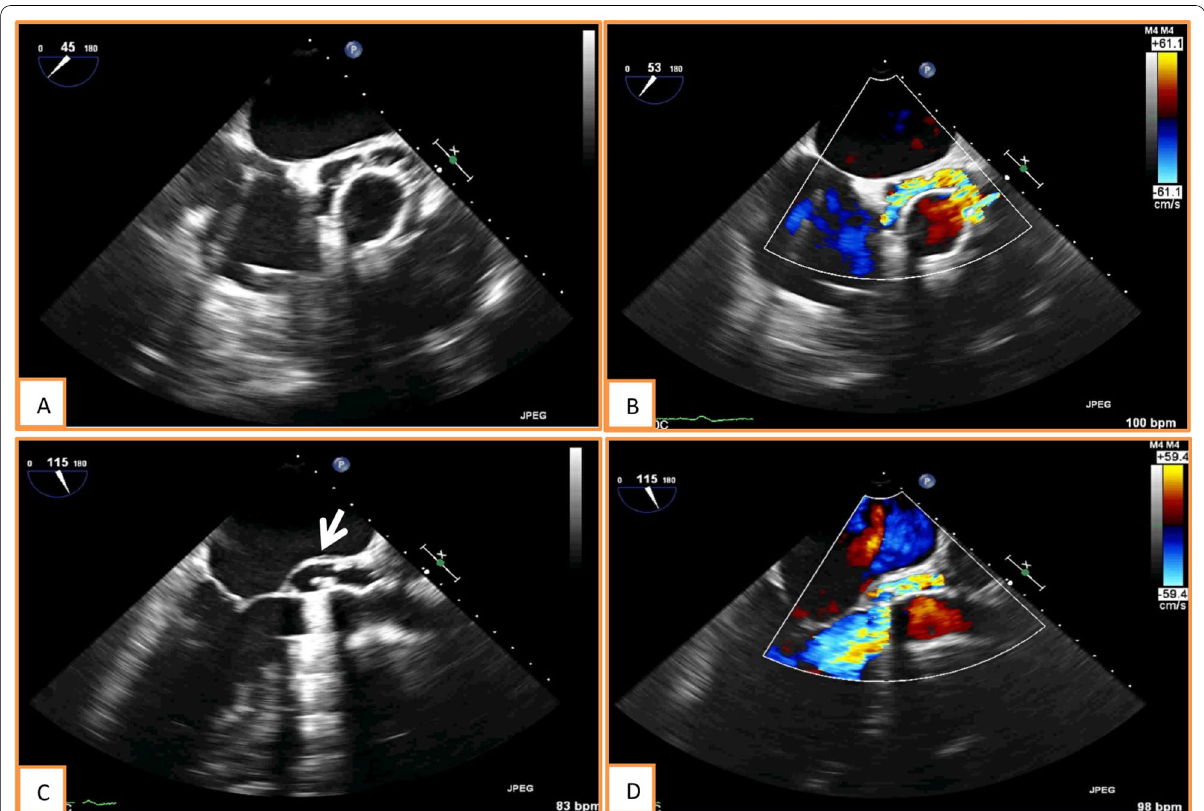
Fig. 1 Transesophageal echo A short-axis (SA) view showing dehiscence (arrow); B SA color Doppler; C pseudoaneurysm in 3-chamber view (arrow); D 3-chamber color Doppler